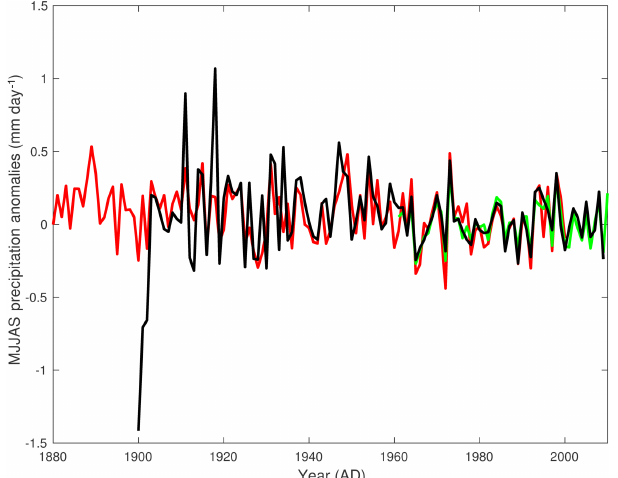
Figure 5. The intrinsic mode functions (IMFs) of the mean MJ- JAS precipitation anomalies for eastern China (blue line), western China (red line), and the whole of China (black line), over the past 531 years (AD1470–2000) using the ensemble empirical mode de- composition (EEMD) method, including the multidecadal compo- nent (a) , centennial component (b) , and long-term trend (c)